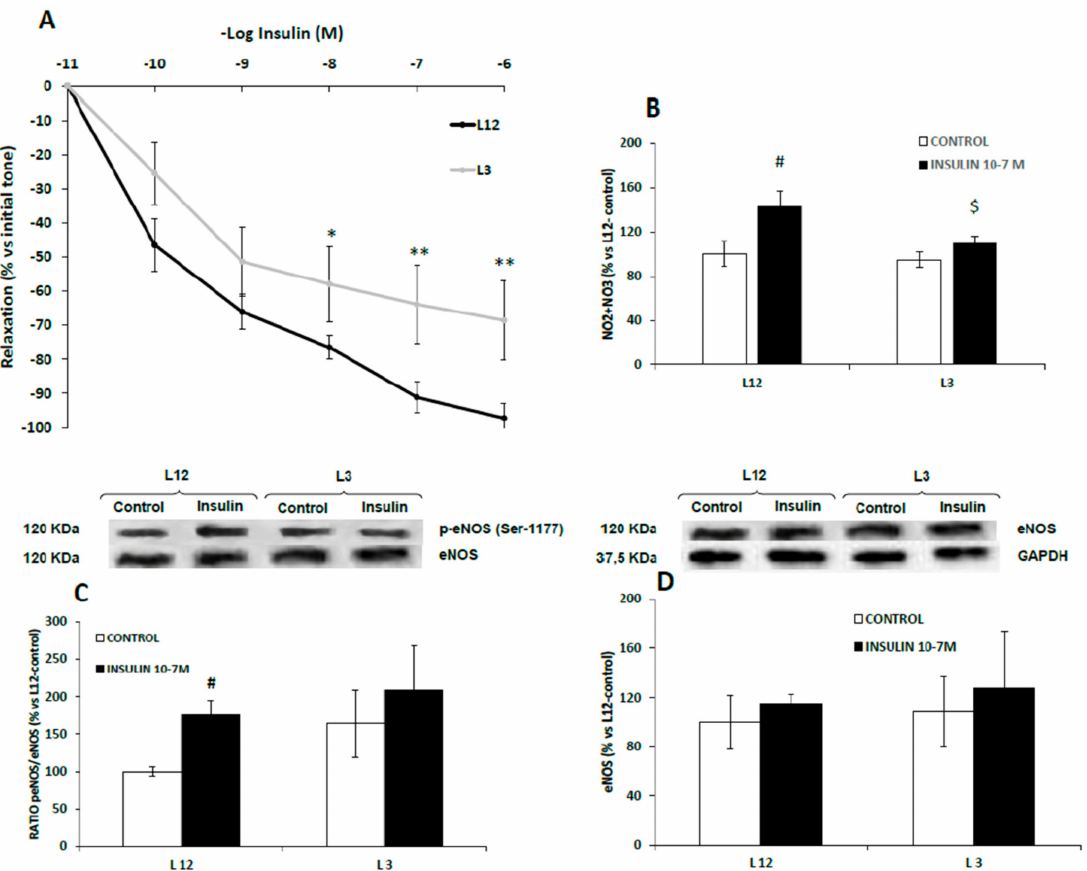
Figure 5. Relaxation to insulin (10 − 11 –10 − 6 M) of precontracted aortic rings ( A ), nitrite and nitrate release ( B ), ratio of phosphorylated to total eNOS (p-eNOS / eNOS) ( C ) and total eNOS (eNOS) ( D )